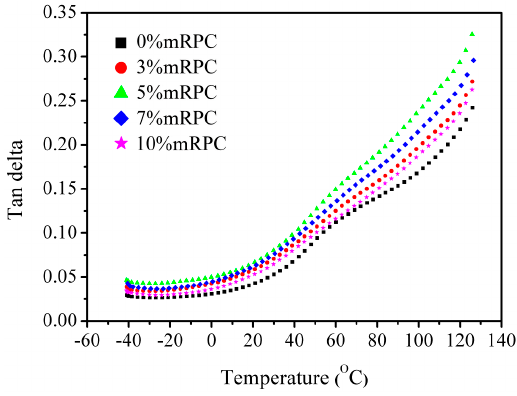
Figure 6. Loss-tangent curve obtained for the mRPC/HDPE/wood fiber composites.